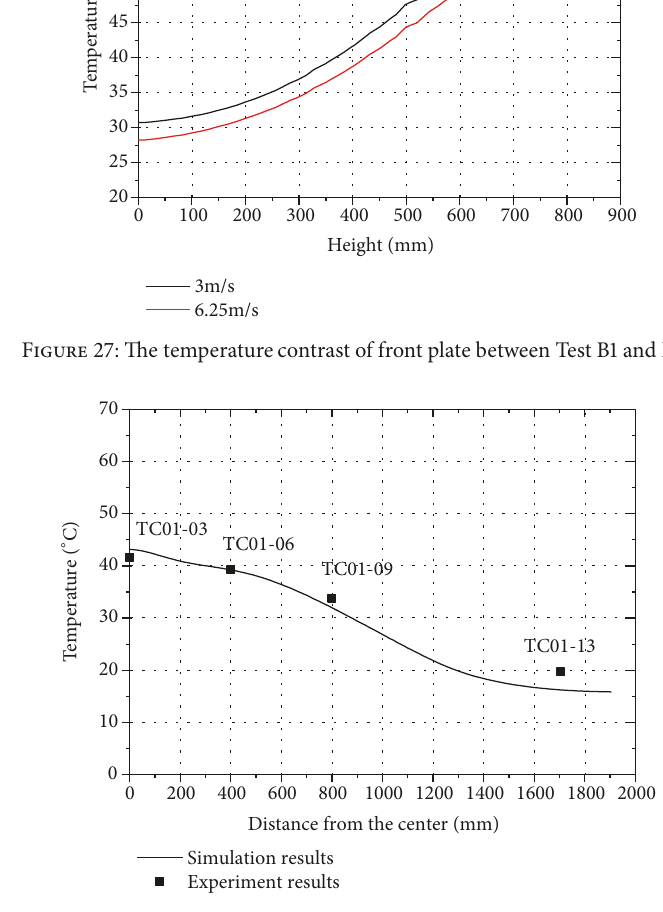
Figure 28: The temperature contrast of simulation and experiment at the support bottom plate in Test